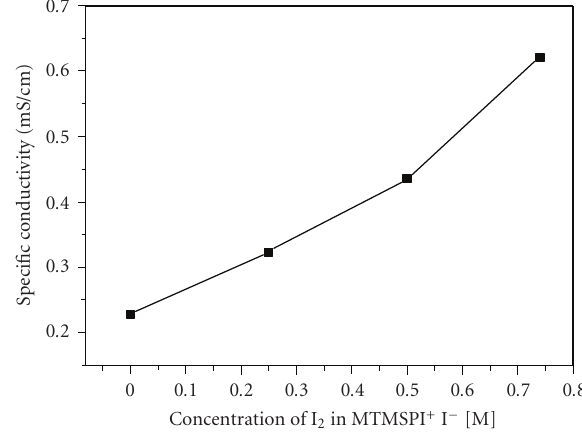
Figure 6: Changes of the specific conductivity of nonhydrolyzed (closed squares) and hydrolyzed (0 . 1M HCl) MTMSPI + I − aged 24h (closed circles).